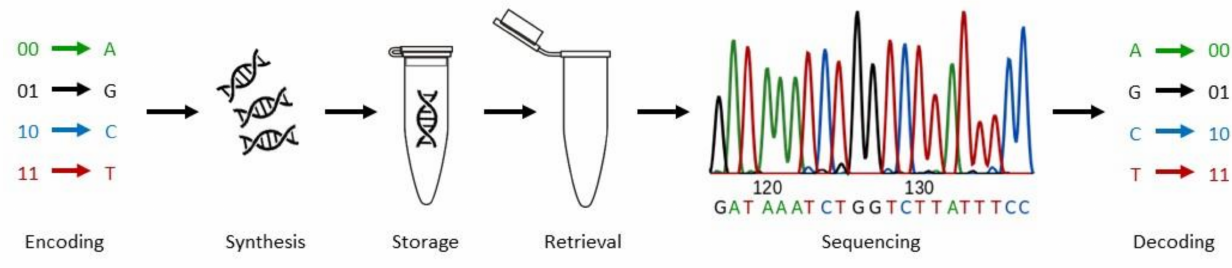
Figure 5. Information storage using DNA. Adapted from https://www.twistbioscience.com/products/storage (accessed on 8 December